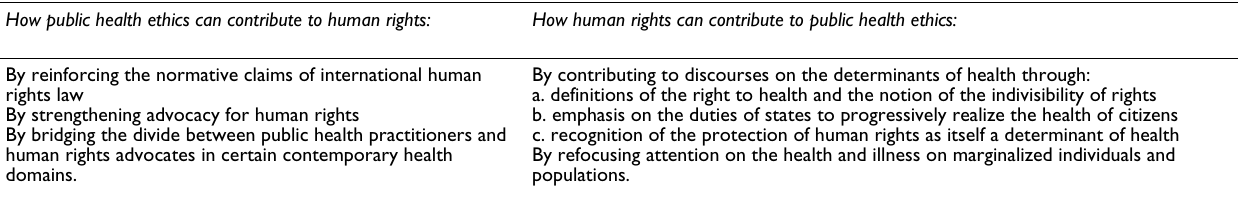
Table 1: Complementarities between public health ethics and human rights How public health ethics can contribute to human